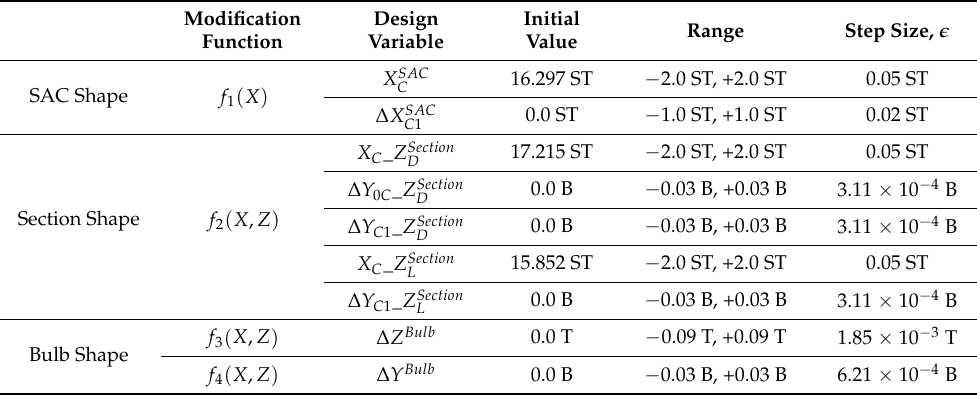
Table 6. Initial value and range of design variables for SQP